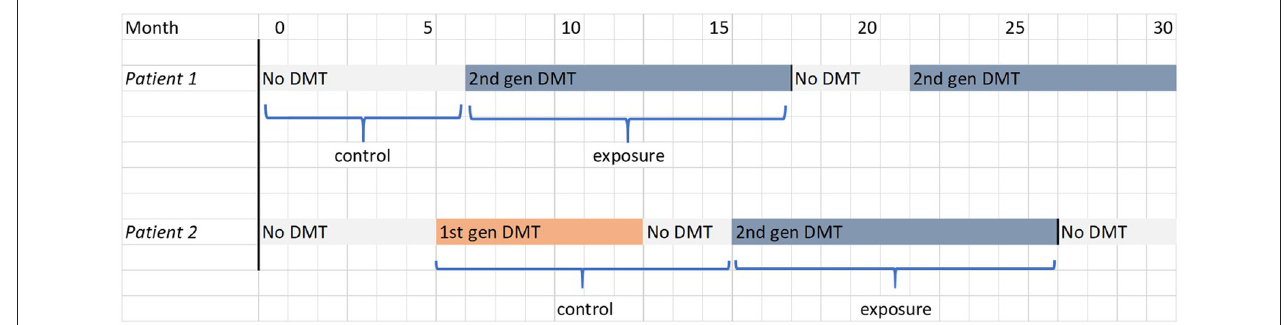
FIGURE 1 | FigIllustrations of the determination of exposure and control periods in the primary cohort analysis for two hypothetical patients, one in each stratum. The filled blocks represent the treatment received by the patient; the labels below indicate the periods of follow-up that contribute to the analysis.